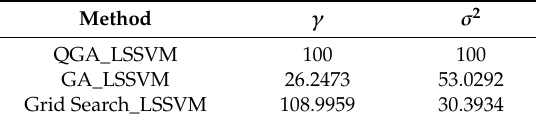
Table 12. The optimized parameters for the current signal.